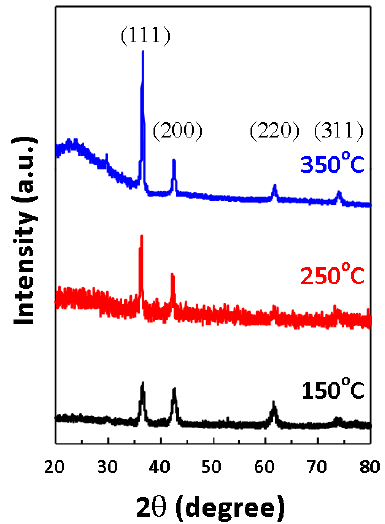
Figure 1. X-ray diffraction (XRD) patterns of Cu temperatures of 150 °C, 250 °C and 350 °C, respectively.